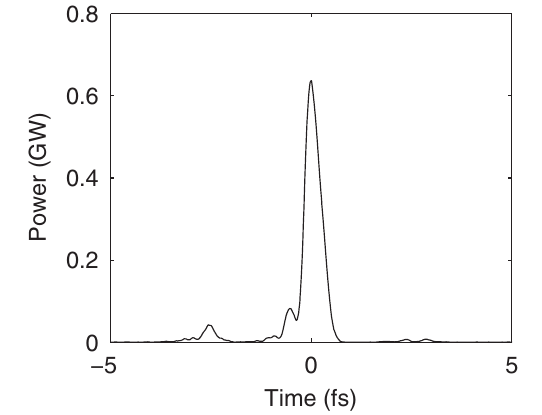
FIG. 7. Wigner transform of the radiation field at 34.4 m for the 800 nm modulating laser case. The radiation emitted at earlier times is clearly visible at shorter wavelengths.